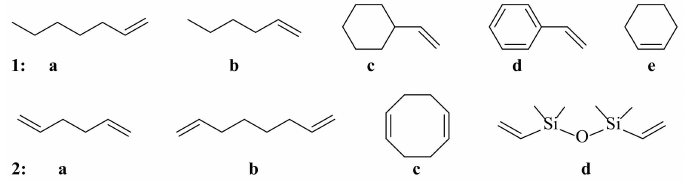
Figure 2. The studied alkenes 1a – e and dienes 2a – d